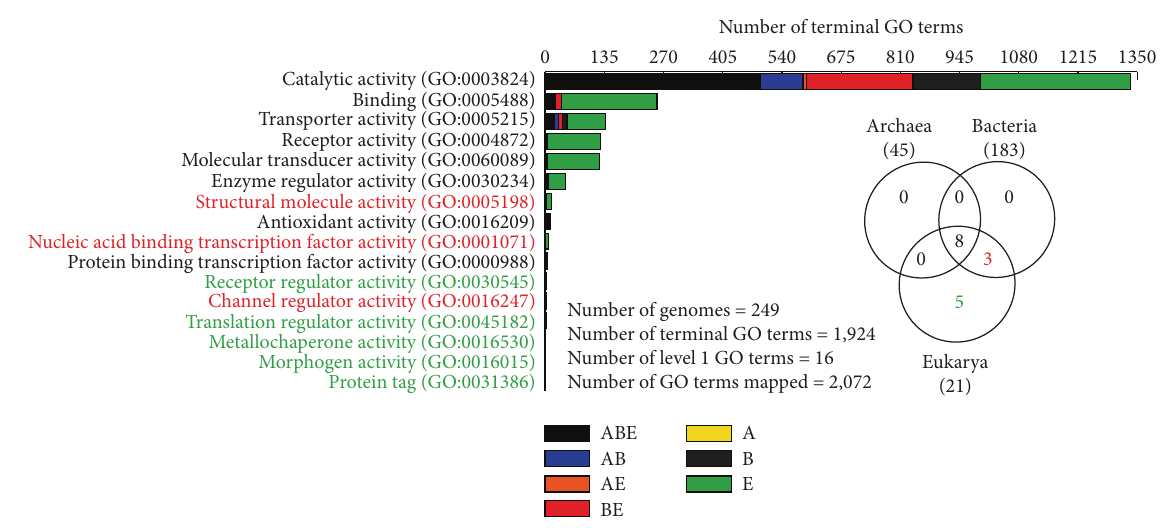
Figure 5: Bar plots illustrating the breakdown of terminal GOs in the seven taxonomic groups for level 1 GO terms. A total of 1,871 out of 1,924 GOs (97.24%) could be reliably mapped to their parents. Level 1 GOs that could not be mapped include “D-alanyl carrier activity [GO:0036370],” “electron carrier activity [GO:0009055],” “chemoattractant activity [GO:0042056],” “chemorepellent activity [GO:0045499],” and “nutrient reservoir activity [GO:0045735].” Note that terminal GOs may have more than one parent. The Venn diagram shows that none of the A, B, AB, and AE taxonomic groups uniquely code for any level 1 GO